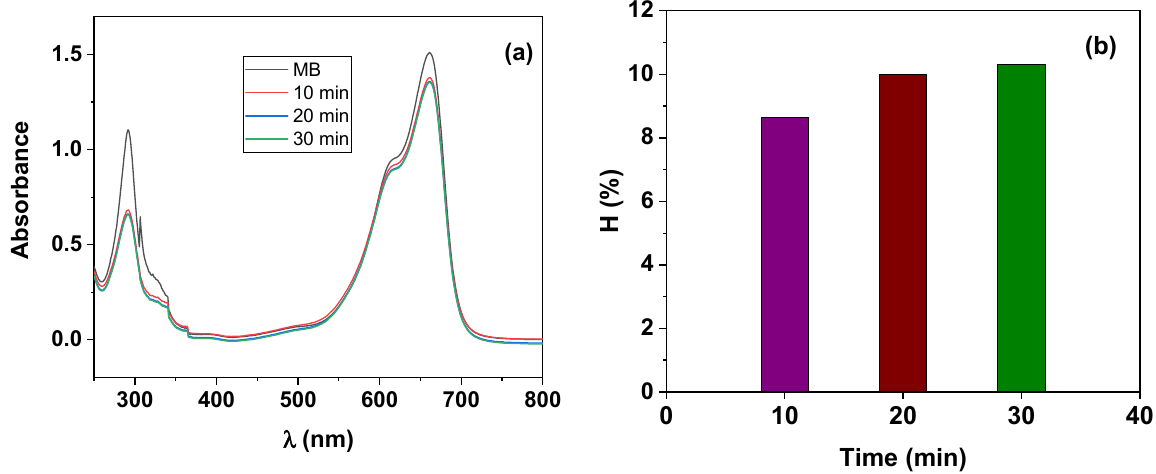
Figure 9. UV–vis absorbance spectra of MB under dark adsorption ( a ) and adsorption percentages of 5% CuO/STO/MWCNTs ( b ).